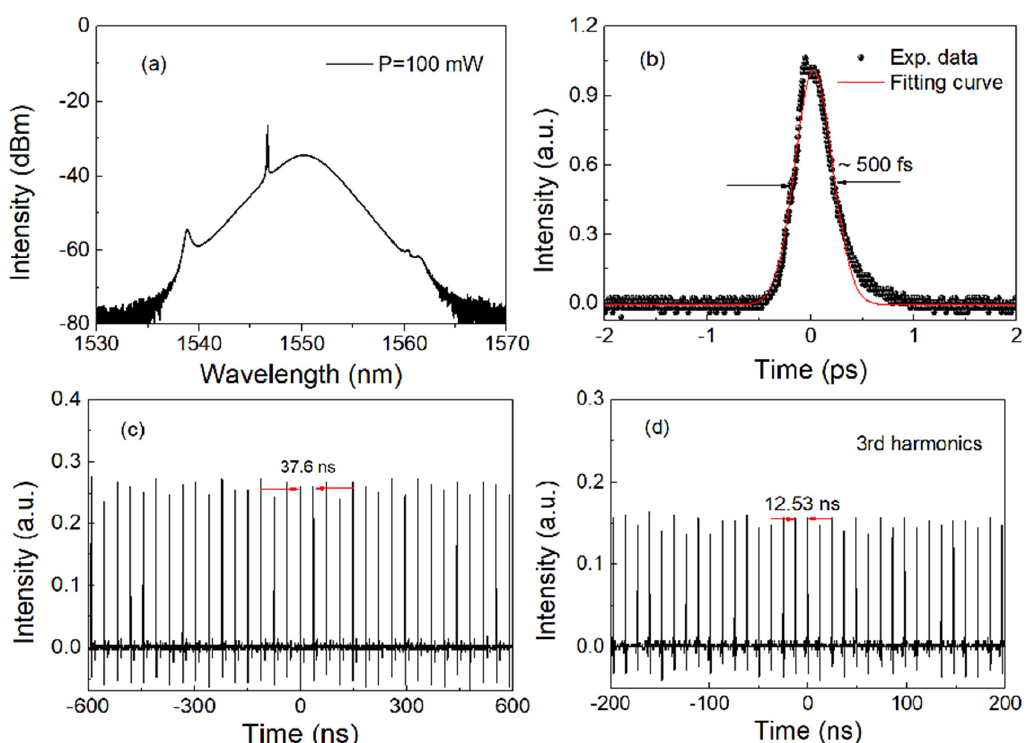
Figure 4. Typical characteristics of conventional soliton pulses: ( a ) optical spectrum; ( b ) autocorrelation trace; ( c , d ) oscilloscope’s traces of soliton pulse and its triple form. where c, λ c , and δλ are the light speed, center wavelength, and spectral modulation period. In this experiment, these parameters are c = 3 × 10 8 m/s, λ c = 1550.2 nm, and δλ = 1.53 nm, respectively. Thus, the soliton separation ∆ τ is about 5.23